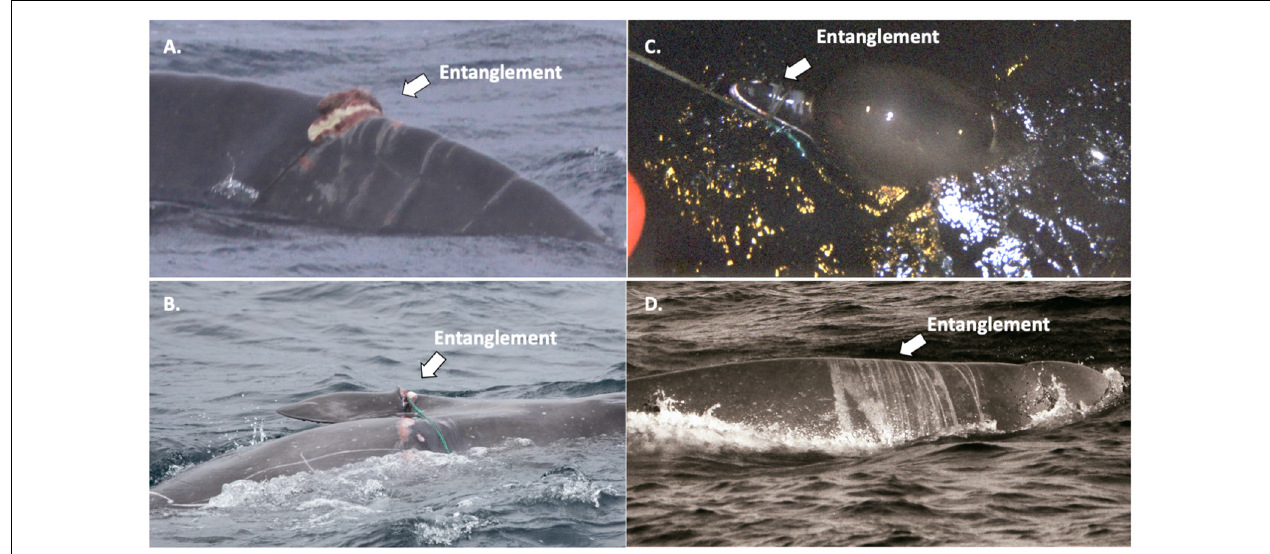
FIGURE 6 | Examples of entanglement used for comparative analysis of scar patterns (A,B) depict two different entangled Sowerby’s beaked whales observed in the Gully MPA in 2013; (C) a northern bottlenose whale entangled in the Davis Strait in 2003 with a longline buoy line wrapped around its beak; and (D) a male northern bottlenose whale in the Gully in 1990 with multiple wrapping scars around its body.